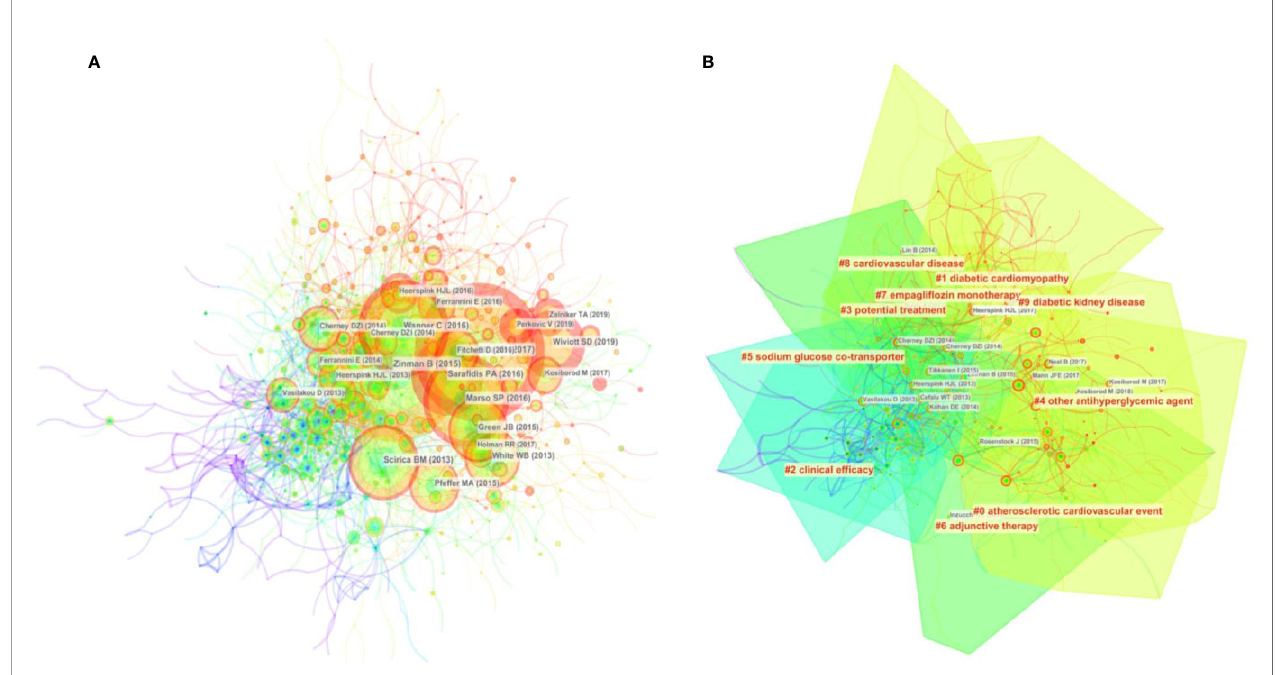
FIGURE 4 | Analysis of references to SGLT2 inhibitors in cardiovascular research. (A) Network map of co-cited references. (B) Network map of co-cited